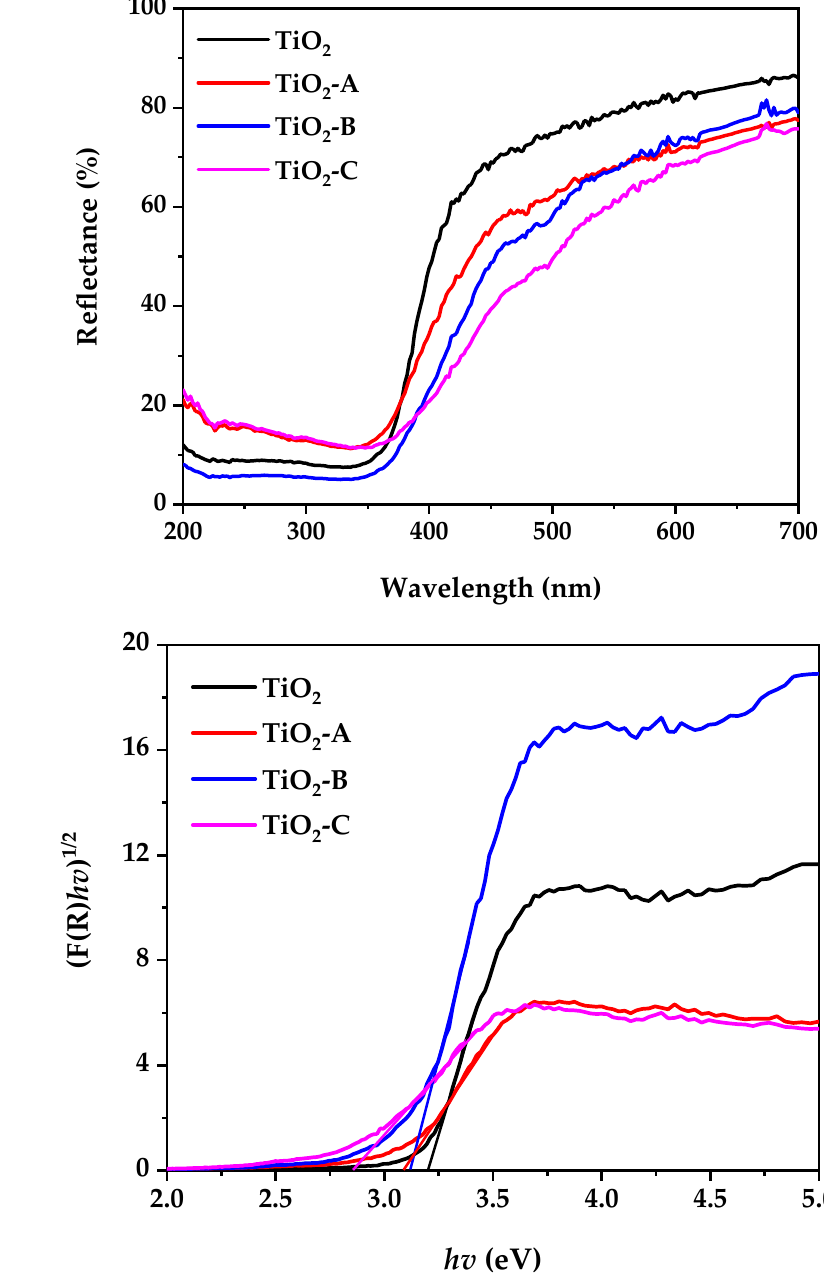
Figure 4. ( a ) UV-visible diffuse reflectance spectrum, ( b ) Kubelka–Munk plot for bandgap calcula- tion.